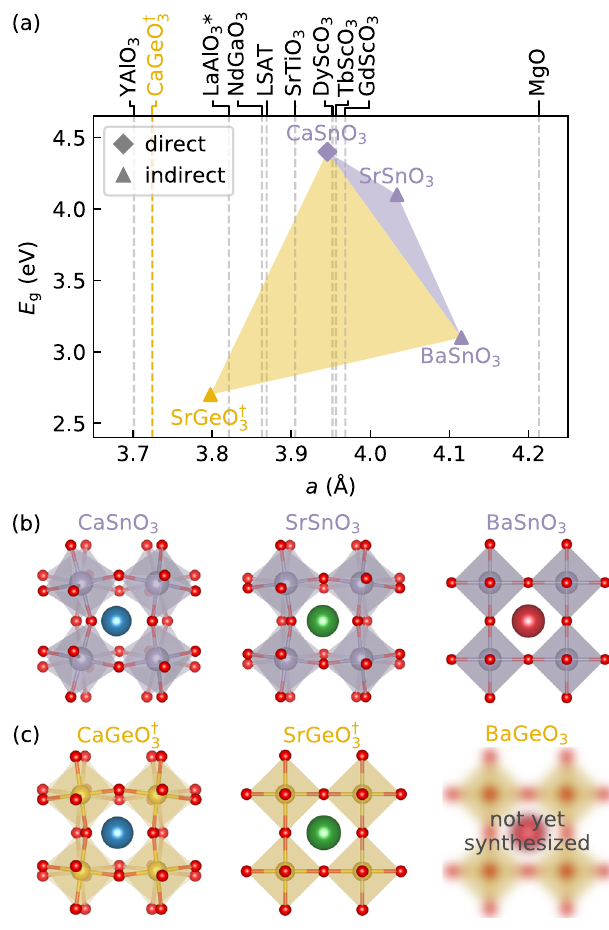
Fig. 1 Summary of alkaline-earth stannates and alkaline-earth germanates. a Bandgap ( E g ) vs pseudocubic lattice parameter ( a ) of alkaline- earth stannates and alkaline-earth germanates, SrGeO 3 . The purple shaded region represents values of E g and a that are available to alloys of the three materials. The yellow region represents those additional values that are available when including perovskite SrGeO 3 in the alloy system. The lattice parameters of commercially available substrates are shown as vertical lines. b Crystal structures of alkaline-earth stannates. c Crystal structures of alkaline-earth germanates. All stannate perovskite structures are from ref. 37 . The CaGeO 3 structure is from ref. 10 . The SrGeO 3 structure is from ref. 26 . † Denotes metastable crystal structures that were quenched to ambient conditions. *Denotes a rhobohedral distortion at room